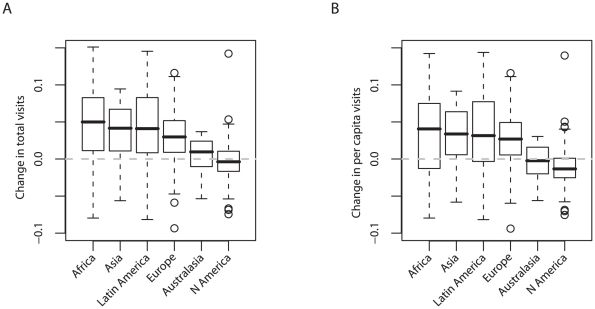
Comparisons across continents of rates of change in numbers of visits to protected areas, 1992–2006; lines, boxes, error bars, and circles show medians, interquartile ranges, minima and maxima (excluding outliers), and outliers (which deviate from the median by >1.5× interquartile range), respectively.(A) Changes in total visit number; (B) changes in per capita visit number.